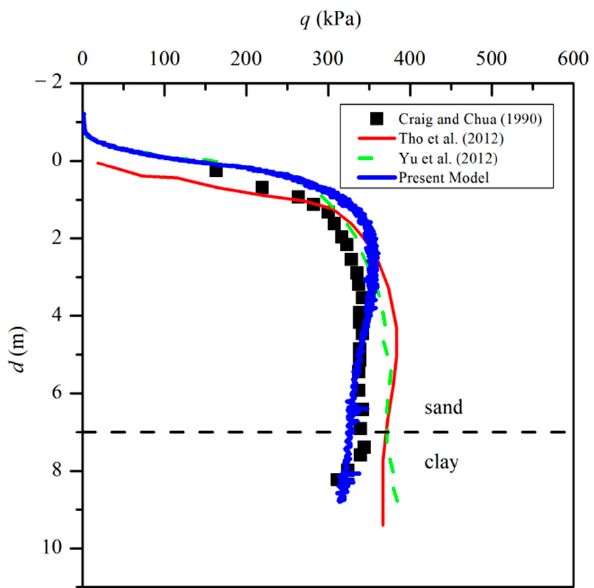
Figure 10. Penetration resistance profiles from centrifuge tests and numerical analyses (loose sand overlying clay) [7,18,19].